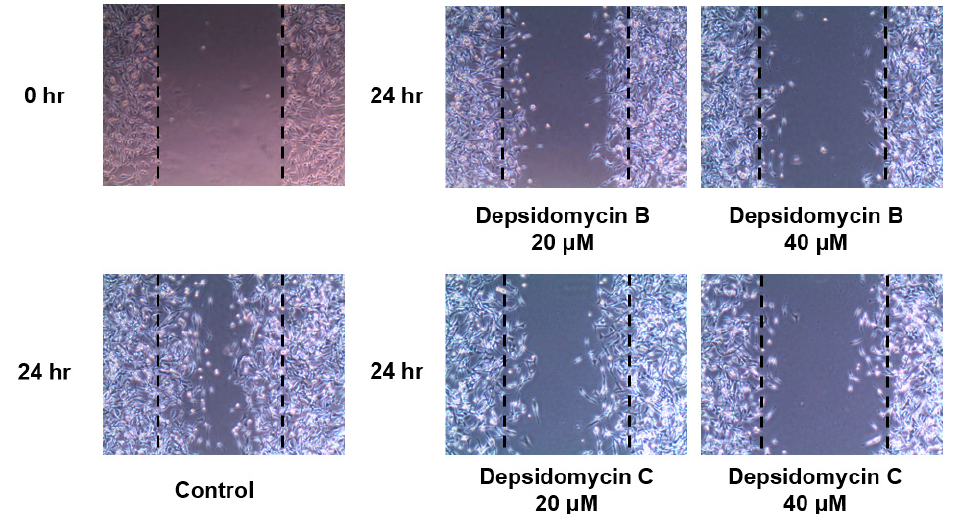
Figure 5. Antimetastatic activity against the breast cancer cell line MDA-MB-231.